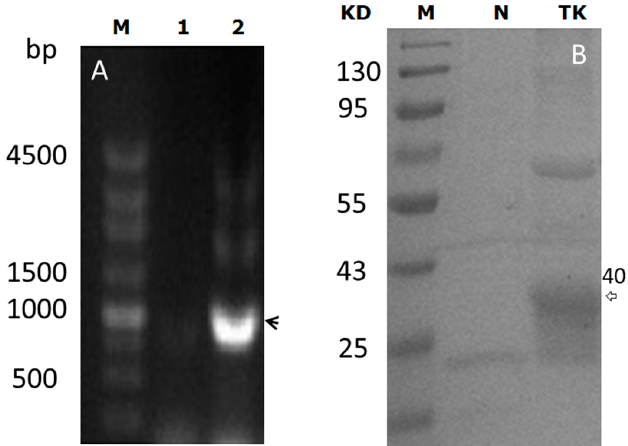
Figure 1. pBEX-tk was expressed in Bifidobacterium (BF). ( A ) PCR results. M: DNA standard molecule; lane 1: Negative control with pBEX template; lane 2: PCR product of tk with pBEX-tk template (black arrow); ( B ) polyacrylamide gel electrophoresis (PAGE) results. M: Protein standard molecule; lane N: Negative control of pBEX; lane TK: Purified TK expressed in pBEX-tk with His-tag (white arrow).